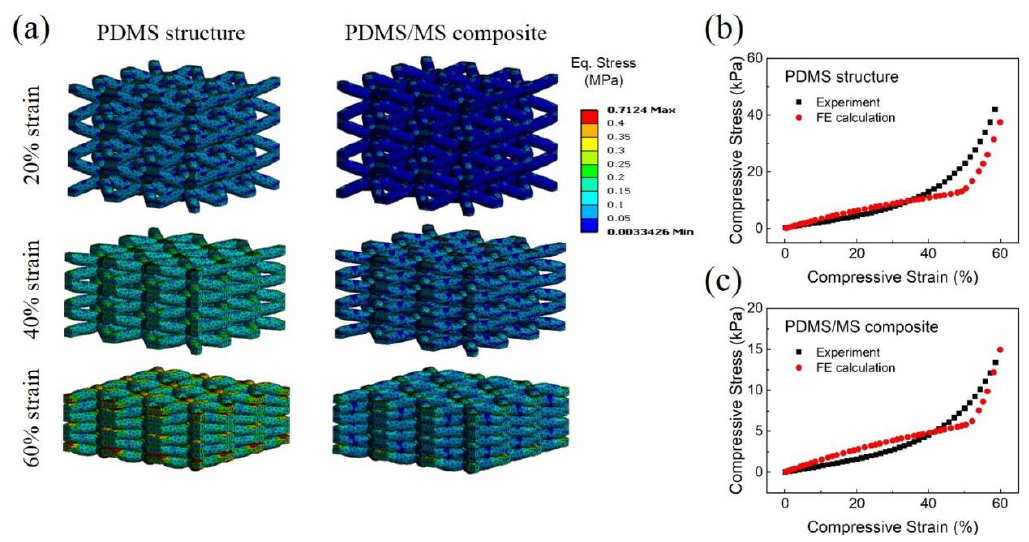
Figure 4. FE simulation for comparison of the compressive behavior of porous PDMS structure and PDMS / MS composite. ( a ) Evaluation of equivalent compressive stress of PDMS structure vs PDMS/MS composite. ( b ) Compressive stress–strain curves of the PDMS structure by experiment and FE calculation. ( c ) Compressive stress–strain curves of the PDMS / MS composite by experiment and FE calculation.